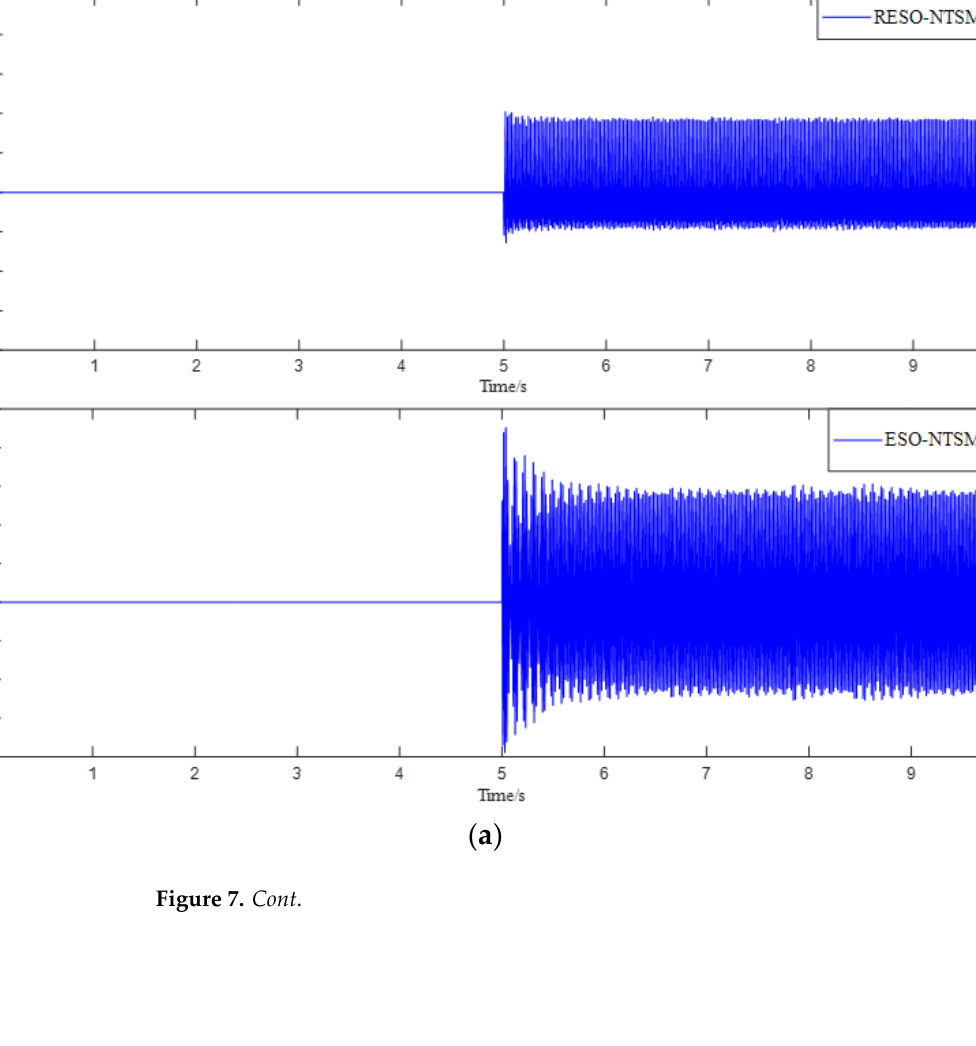
14 of 17 Figure 6. Frequency domain diagram: ( a ) global frequency curve; ( b ) local frequency curve near 48.5 Hz; ( c ) local frequency curve near 97 Hz; ( d ) local frequency curve near 194 Hz; ( e ) local frequency curve near 242.5 Hz; ( f ) local frequency curve near 339.5 Hz.